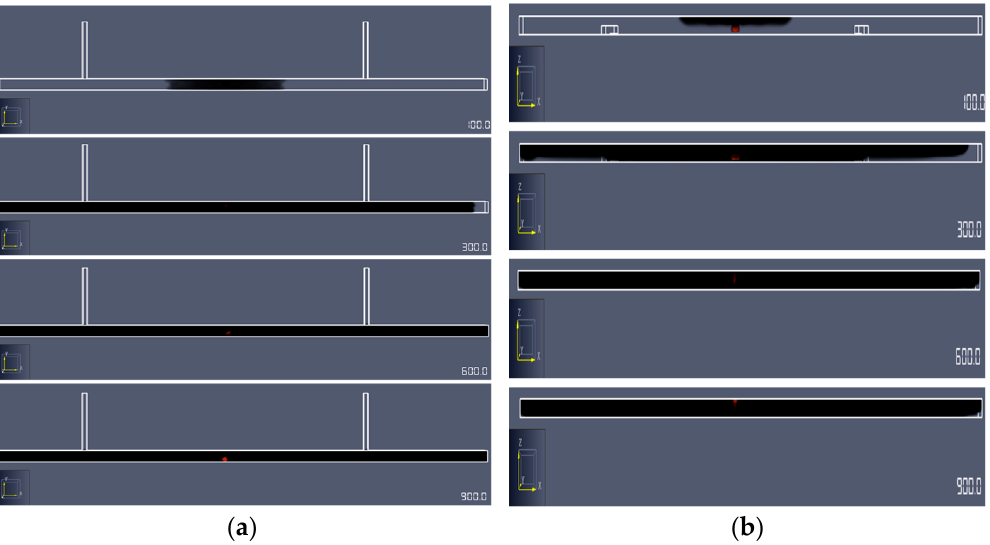
Figure 3. Schematic diagram of flue gas development without longitudinal ventilation: ( a ) top view; ( b ) front view.